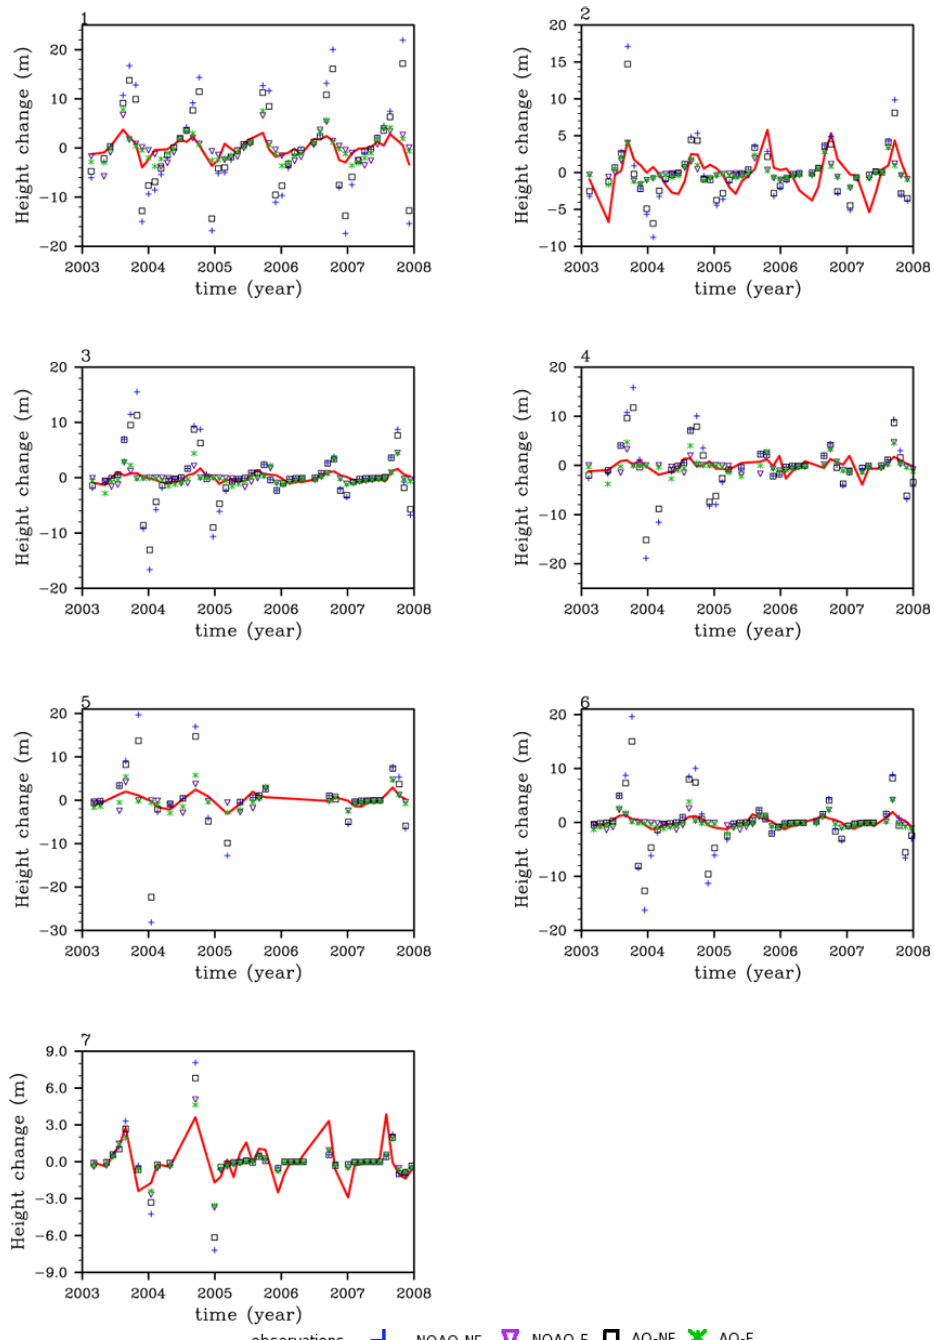
Fig. 11. Water level changes when the model is forced by